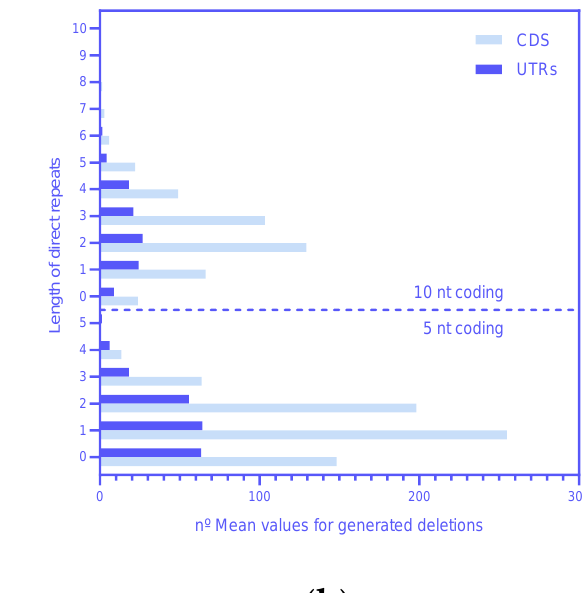
Figure 4. Association of long deletions with inverted repeats. ( a ) Number of matches between repeated fragments. ( b ) Mean values for the generated deletions. Heatmap of the association of long deletions with inverted repeats in UTR and CDS expressed as the number of matches between repeated fragments is shown in the Figure S6.